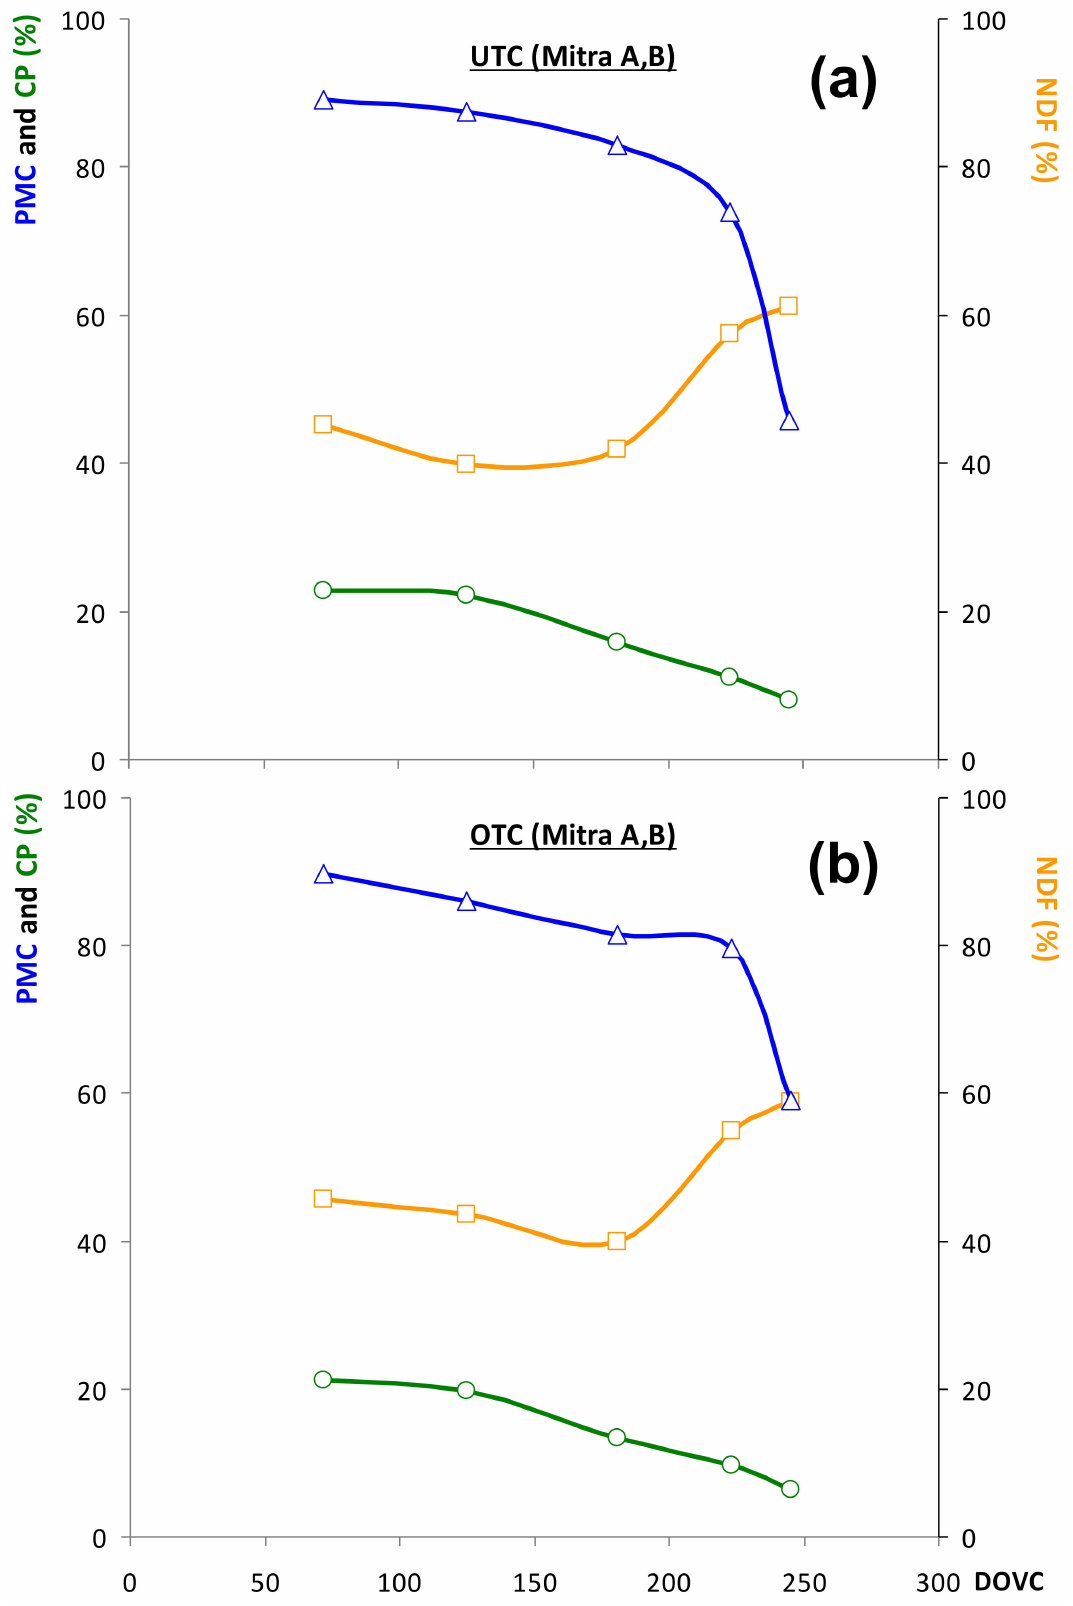
Figure 6. Evolution of the pasture quality parameters throughout the vegetative cycle, under tree canopy (UTC; ( a )) and outside tree canopy; (OTC; ( b )). DOVC, day of the pasture vegetative cycle; PMC, pasture moisture content; CP, crude protein; NDF, neutral detergent